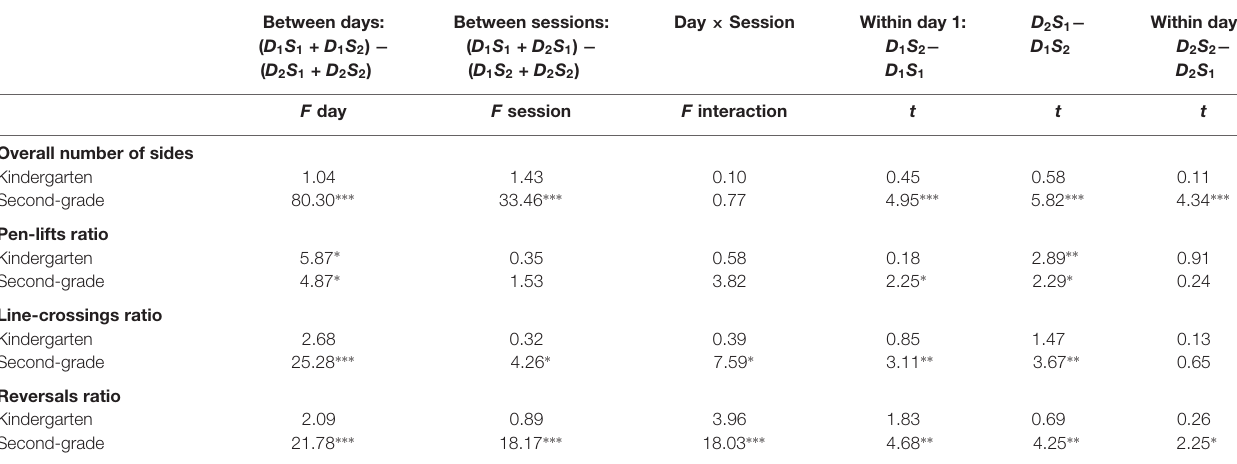
TABLE 2 | Within-group comparison of kinematics measures across sessions and days . Between days: Between sessions: Day × Session Within day